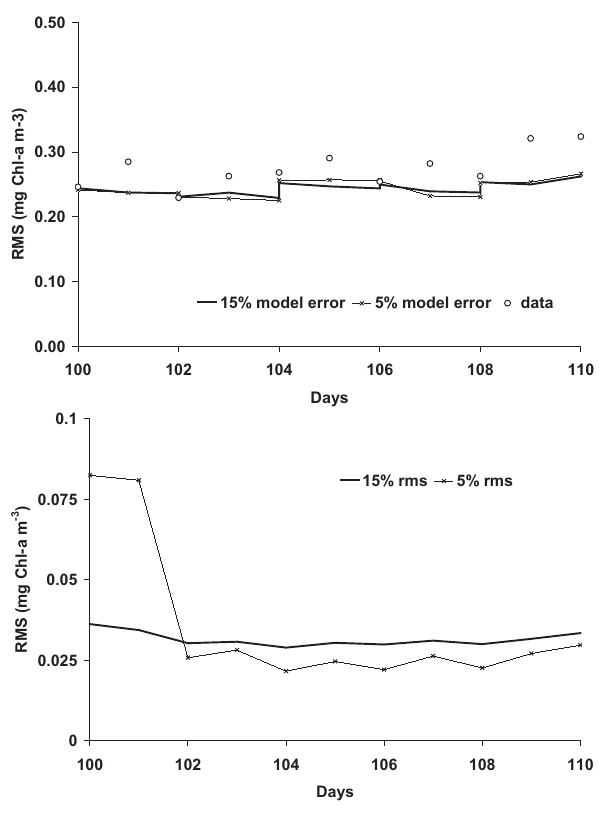
Fig. 13. The influence of the size of the error in the model upon (a) chlorophyll assimilation and (b) the